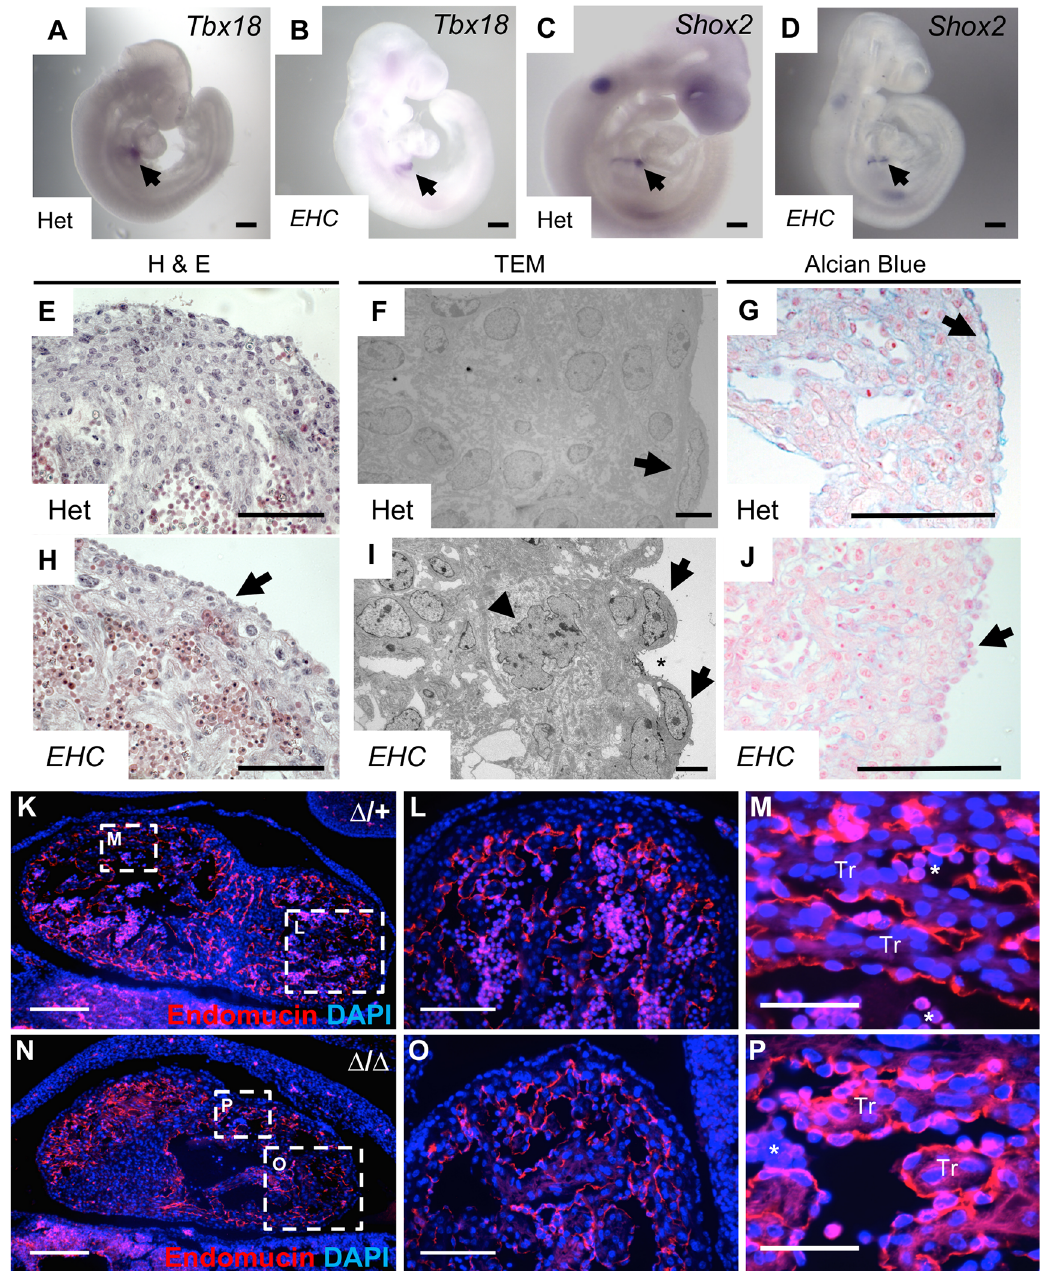
Fig 7. EHC mutants display epicardial defects. A: In situ hybridisation demonstrating Tbx18 expressionin the proepicardial organ of heterozygous and B: EHC homozygous mutant E9.5 embryos (arrows). C: Shox2 expressionis detected in the sinus venosus of heterozygous and D: EHC homozygousmutant E9.5 embryos (arrows). The expressionpatterns of Tbx18 and Shox2 are indistinguishablebetweencontrols and EHC mutants. E: Heterozygous embryoshave an epitheliallayer comprisedof epicardialcells coatingthe developing ventricle at E14.5. F: Electron microscopy showingE16.5 epicardial cells from heterozygous mice having a flattenedmorphology(arrow) and forming a contiguous layer with adjacent cells. G: Alcian blue staining revealsa layer of glycosaminoglycans in the extracellular matrix betweenthe epicardium and myocardiumin heterozygotes at E11.5 (arrow). H: Epicardialcells are present on the surface of the EHC homozygousmutant myocardium(arrow) at E14.5. I: Mutant epicardial cells are irregularin shape and exhibita roundedmorphology (arrows), which generatesgaps betweenneighbouring cells (asterisk). Subepicardial cells displayevidenceof disruptedcellulararchitecture maintenance (arrowhead). J: EHC mutants lack Alcian blue stainingin the subepicardial tissue domain (arrow). K-M: Endomucinimmunofluorescence staining (red) of control